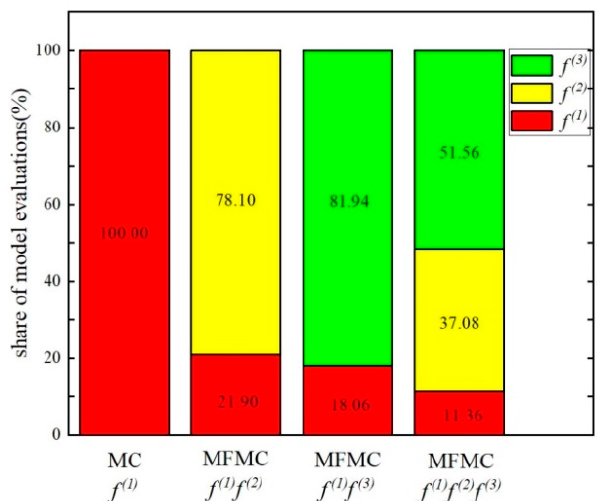
Figure 6. The total number of samples distribution in high-fidelity and low-fidelity models.